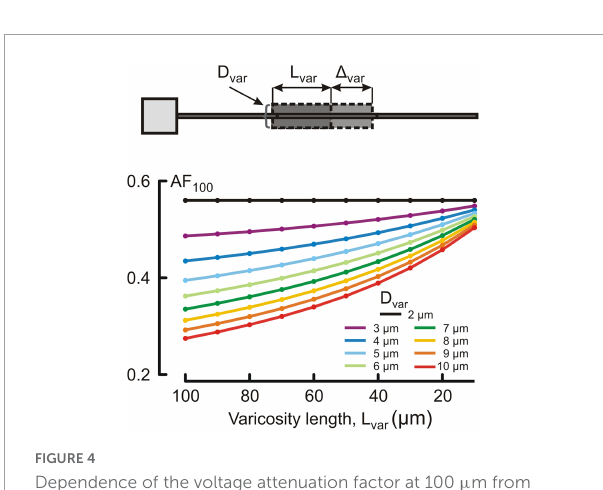
FIGURE4 Dependence of the voltage attenuation factor at 100 µ m from soma AF 100 (ordinate, dimensionless) on the length L var of the varicose section dend2 (abscissa, µ m) for different varicosity diameters D var ( µ m, color coded). FIGURE5